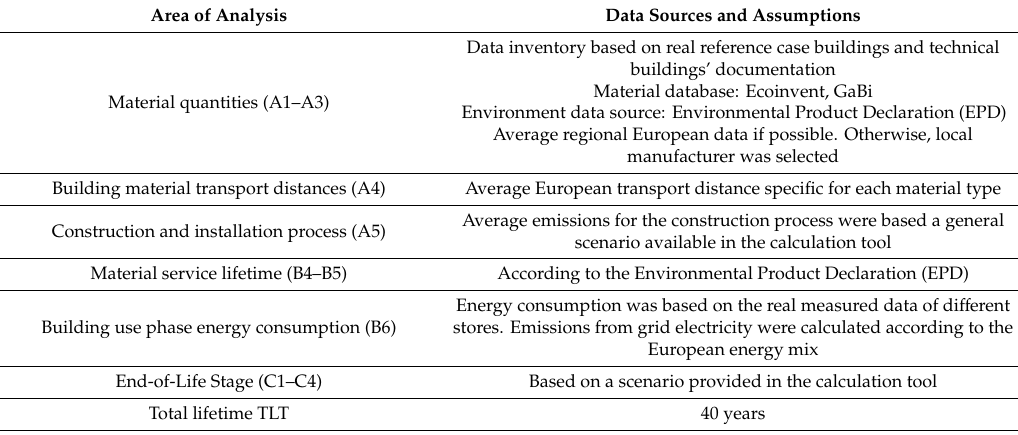
Table 7. Summary of Life Cycle Assessment analysis assumptions for